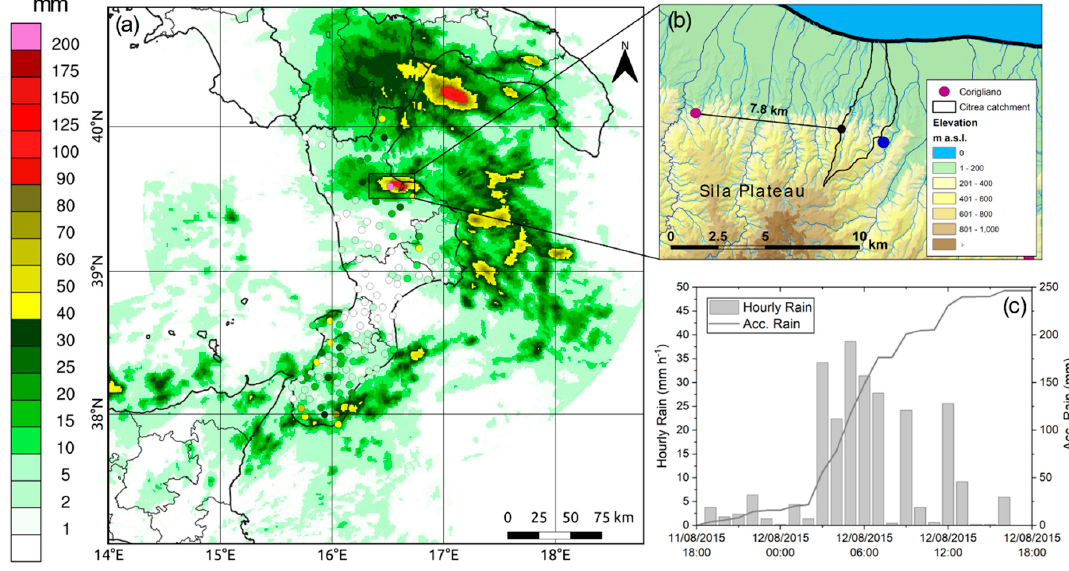
Figure 2. ( a ) The accumulated precipitation observed by the regional monitoring network (dots), overlying the meteorological radar observations during the interval between 1800 UTC, 11 August 2015 and 1800 UTC, 12 August 2015; regional borders are shown together with the coastlines; ( b ) zoom of the study area highlighting both the local orography and river network, which shows a distance lower than 8 km between the Citrea creek catchment and the Corigliano rain gauge; the location of the municipality of Rossano (old city) is indicated with a blue point; ( c ) cumulative and hourly observed hyetograph (mm) at the Corigliano rain gauge.